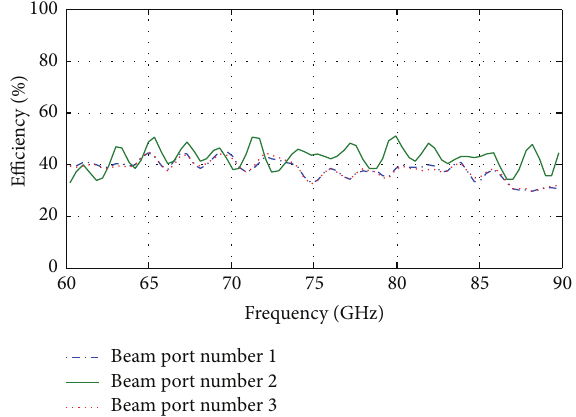
Figure 13: Power efficiency of the proposed Rotman lens for three beam ports.